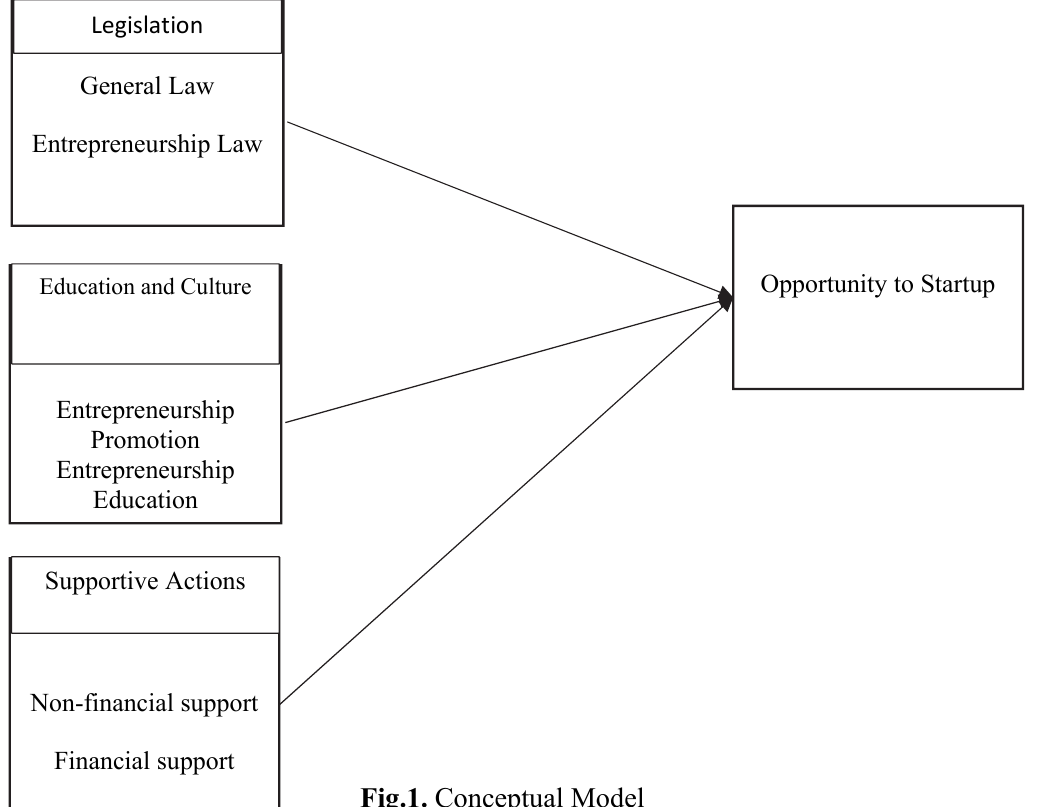
Fig.1. Conceptual